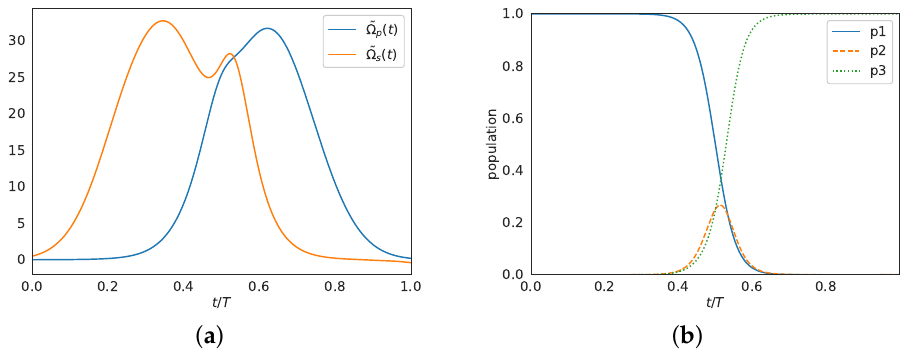
Figure 2. ( a ) Pump and Stokes pulses (in units T − 1 ) for the shortcut to adiabaticity derived from Gaussian pulses. ( b ) Corresponding evolution of populations. Gaussian parameters: Ω 0 = 10 π T − 1 , τ = T /8, and σ = T